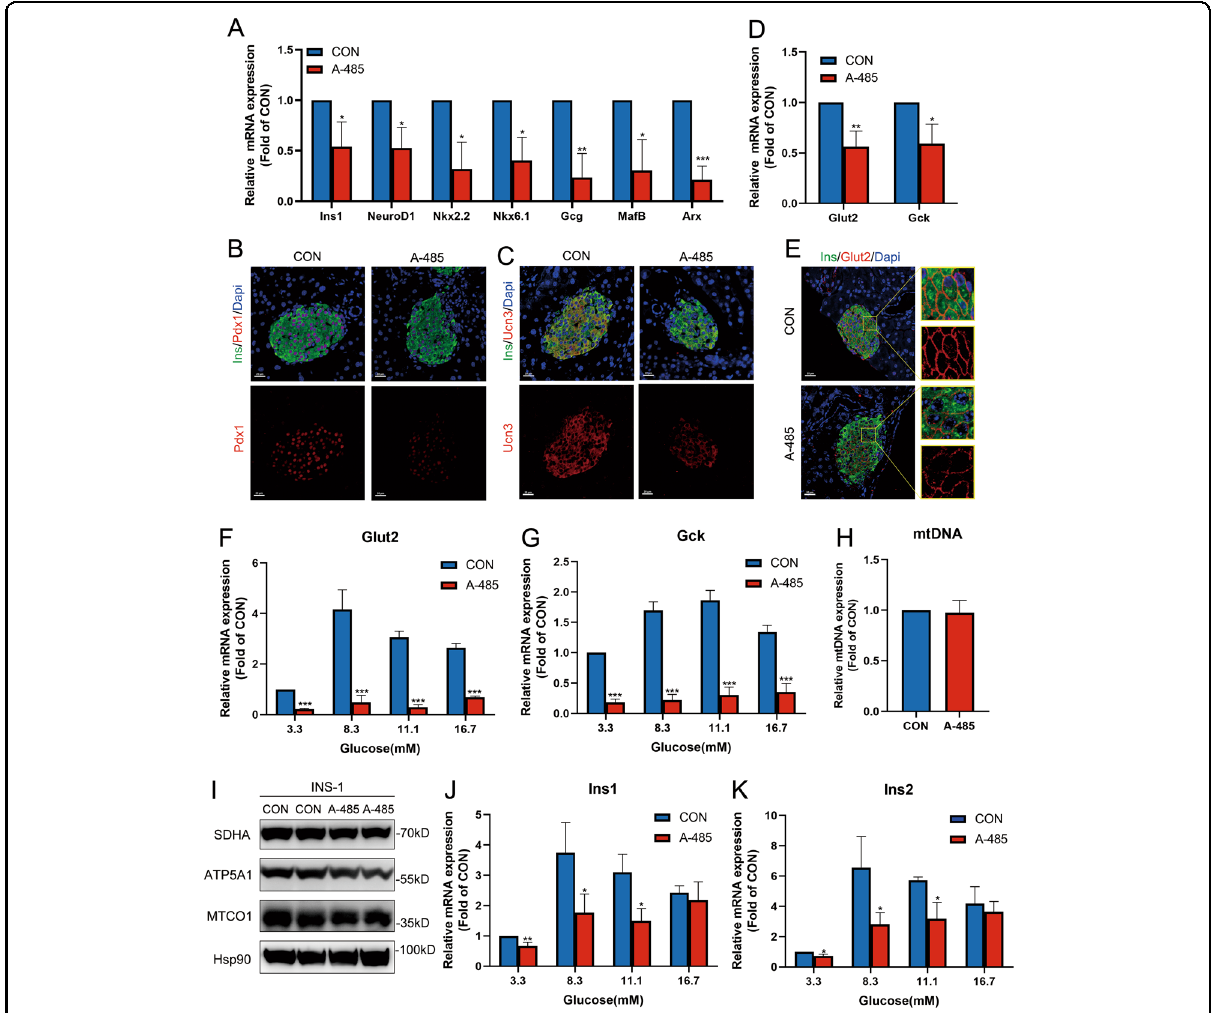
Fig. 3 Impaired β cell identity and functional maturity in CBP/p300 HAT-inhibited β cell. A mRNA expressions of β and α cell identity genes in isolated islets from control and A-485-treated mice. B – C Representative pancreatic sections co-immunostained for insulin (Ins, green), Pdx1 or Ucn3 (red) and DAPI (blue) from control and A-485-treated mice (scale bars, 20 μ m). D mRNA expressions of Glut2 and Gck in isolated islets from control and A-485-treated mice. E Representative pancreatic sections co-immunostained for insulin (Ins, green), Glut2 (red), and DAPI (blue) from control and A-485-treated mice (scale bars, 20 μ m). F – G mRNA expressions of Glut2 and Gck at various concentrations of glucose in isolated rat islets treated with A-485 for 16 h. H mtDNA expression in control and A-485-treated INS-1 cells for 16 h. I Protein expressions of mitochondrial MTCO1, ATP5A1 and SDHA in control and A-485-treated INS-1 cells for 16 h. J – K mRNA levels of Ins1 and Ins2 at various concentrations of glucose in isolated rat islets treated with A-485 for 16 h. Data are given as mean ± SD for three separate experiments. * p < 0.05, ** p < 0.01, *** p < 0.001 vs control